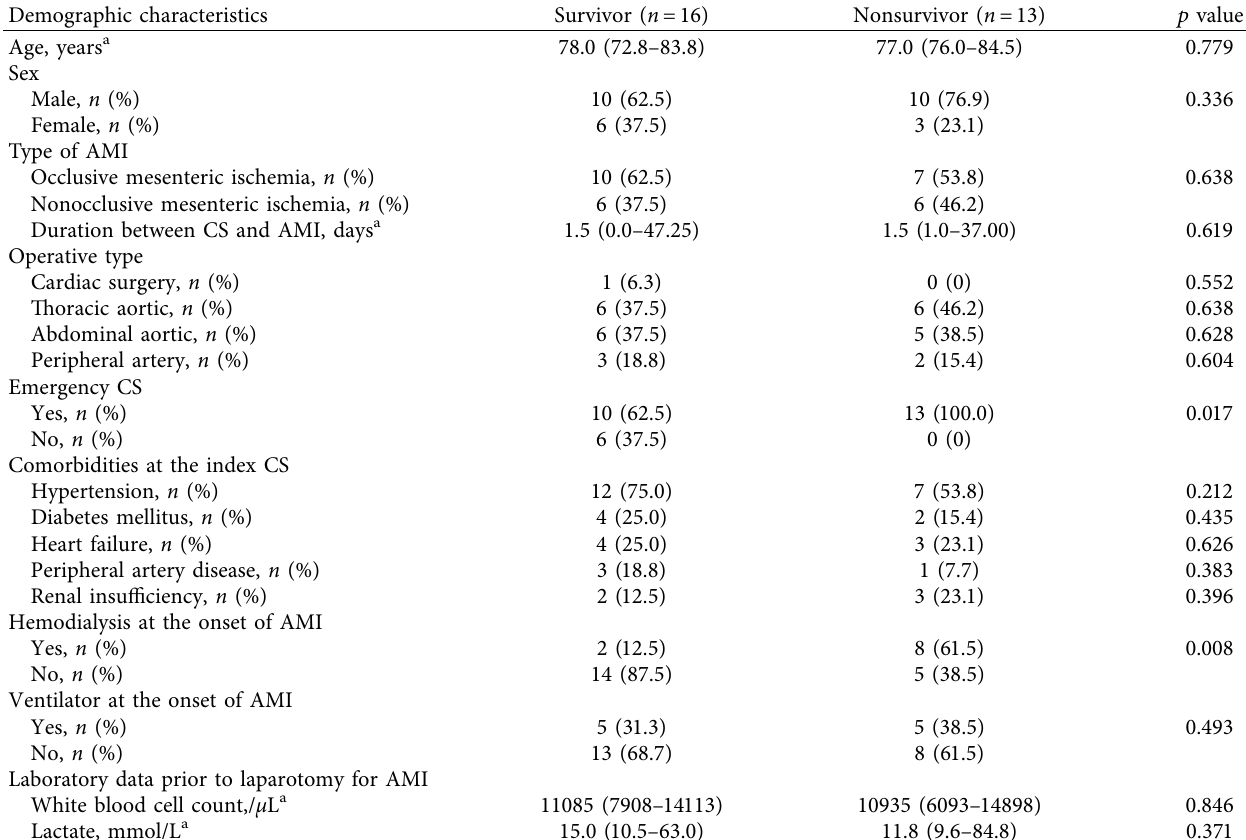
Table 2: Comparison of the demographics of patients between the survivor and nonsurvivor